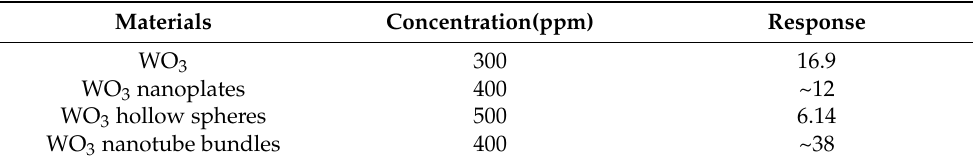
Table 1. WO 3 sensors for ethanol detection reported in literature